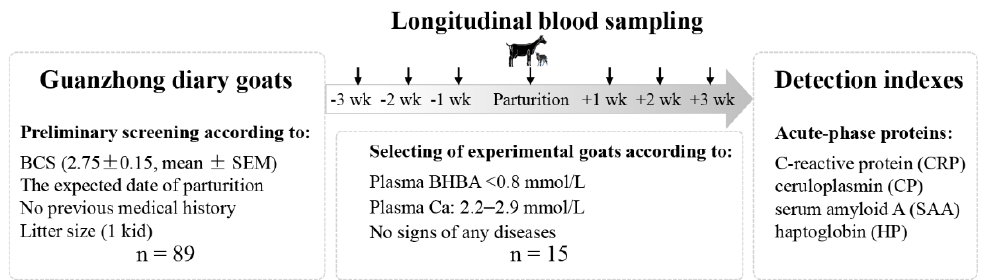
Figure 1. A two-step strategy to screen experimental